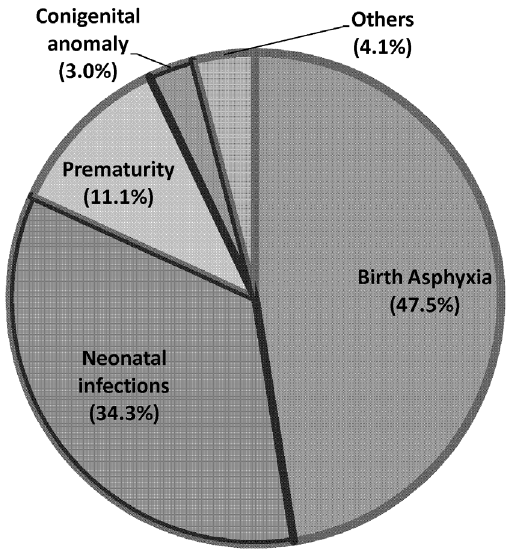
Figure 2. Causes of neonatal death, Jimma Zone, Southwest Ethiopia, Sept 2012–Dec 2013. This figure shows that birth asphyxia (47.5%), neonatal infections (34.3%) and prematurity (11.1%) were the three leading cause of neonatal death accounting for nearly